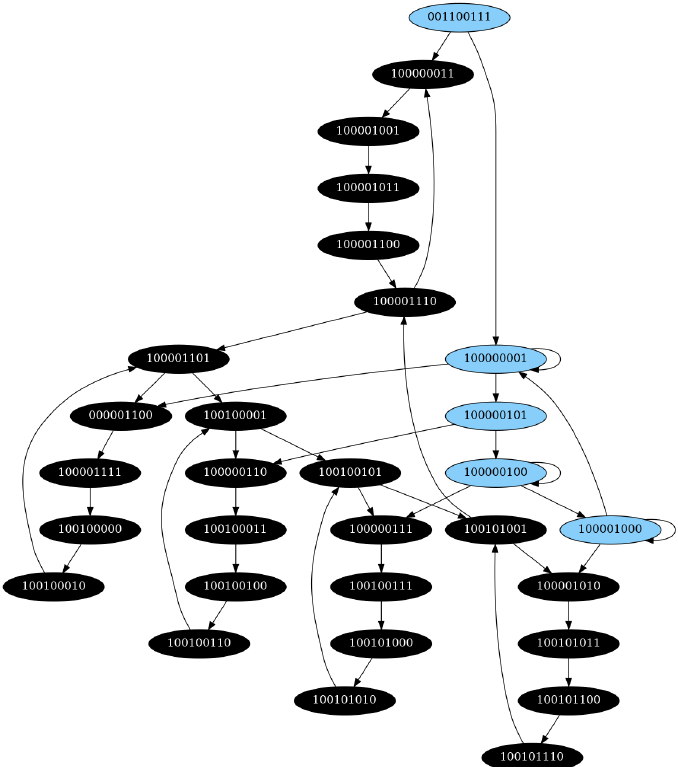
Figure 10: State transition graph of of SHA-3 IP core obfuscated with Active Hardware Metering . Tarjan’s algorithm splits all states into 3 strongly connected components: black hole cluster states (marked in black), original reset state (marked in blue), and original FSM states (marked in blue). Input values for each state transition are deliberately left out for